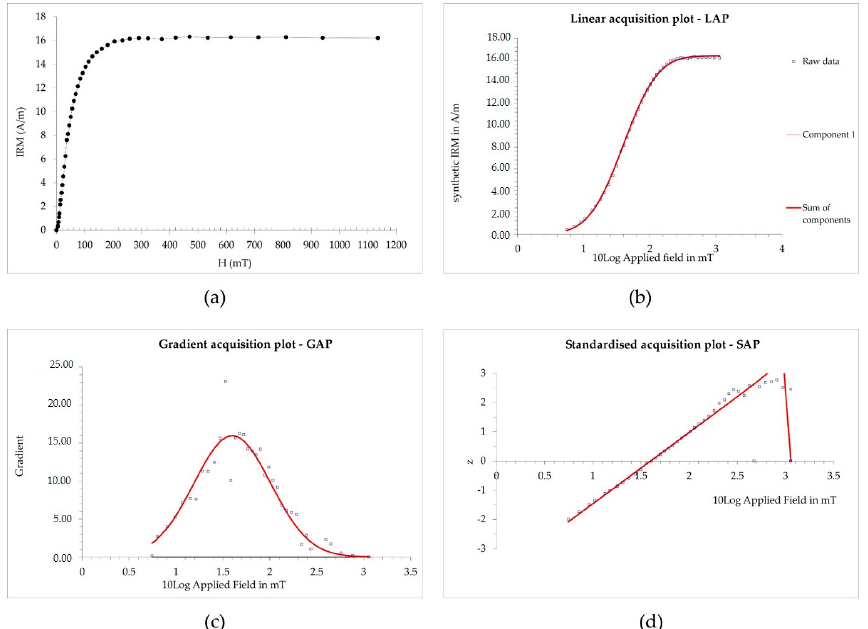
Figure 5. Analyses of ES18-B2 sample using the Kruiver et al. software [1]. ( a ) IRM acquisition curve analyzed using a Cumulative Log-Gaussian (CLG) function. ( b ) IRM curve adjustment versus the logarithm of the field applied to a linear scale (LAP). ( c ) IRM curve adjustment versus the logarithm of the field applied expressed as a gradient (GAP). ( d ) IRM curve adjustment versus the logarithm of the field applied to a probability scale (SAP).